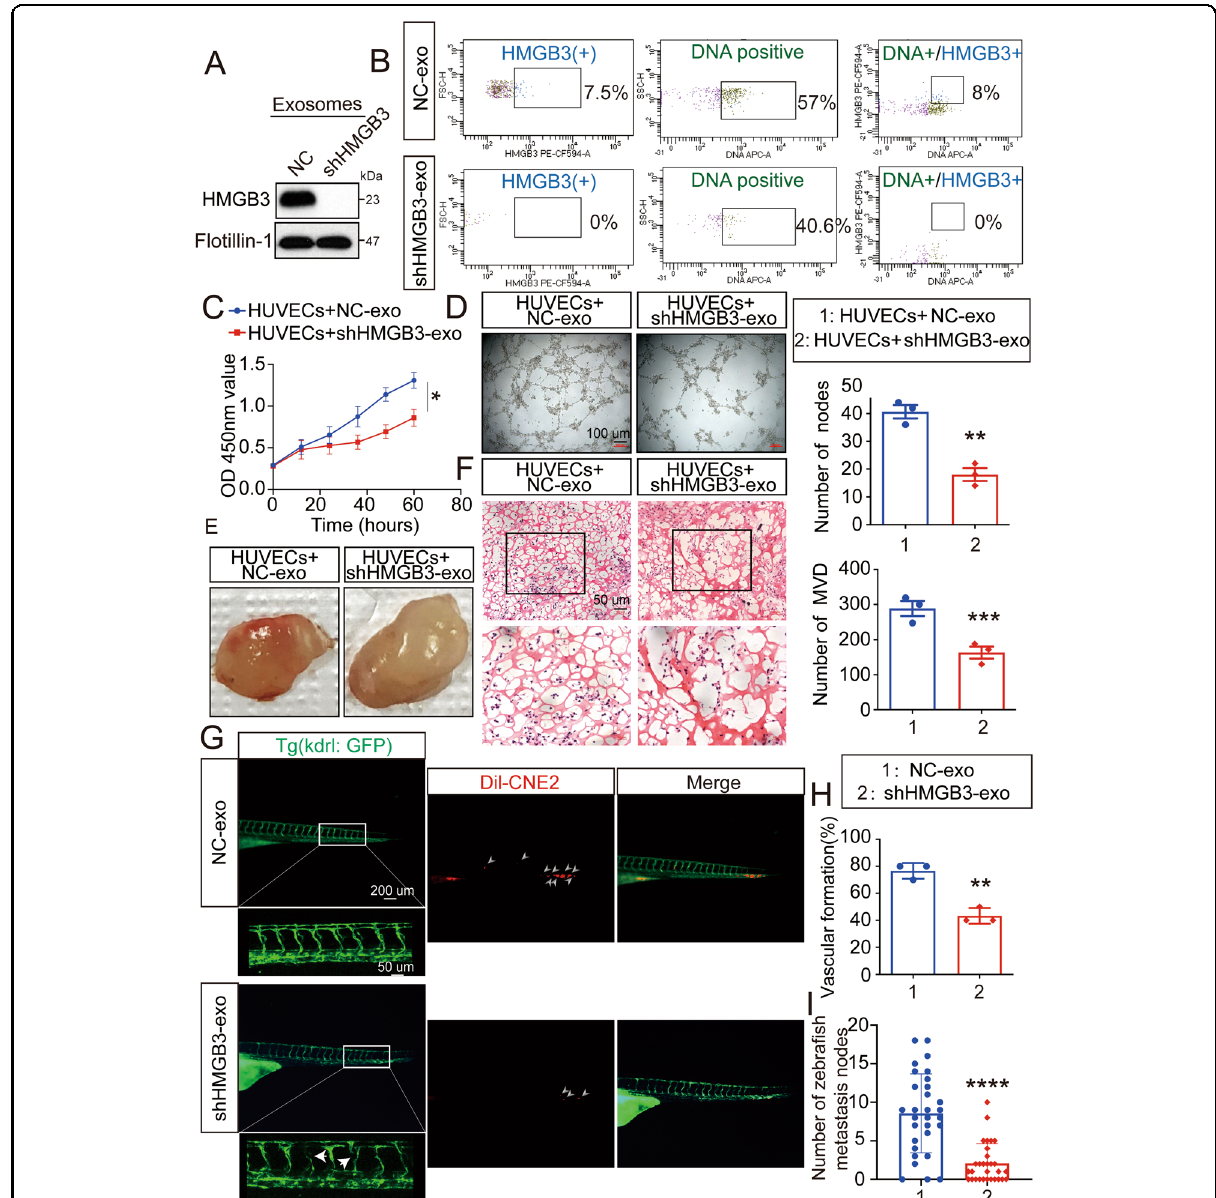
Fig. 7 nEXOs HMGB3 regulates metastasis via angiogenesis. A The HMGB3 levels of CNE2-NC-exo and CNE2-shHMGB3-exo were measured by western blot. B Flow cytometry analysis showed the percentage of gDNA and HMGB3 expression in exosomes of CNE2 cell supernatant. C The CCK8 assays were performed to measure proliferation of HUVECs treated with the two exosomes. D The tube formation assays were performed to measure tube forming ability of HUVECs treated with various exosomes. The scale bar represents 200 μ m. E Gross-observation exosomes modulated angiogenesis. F Frozen slices of the Matrigel plugs were stained with eosin-hematoxylin. The scale bar in 200× images represents 100 µm. The scale bar in 400× images represents 50 µm. G The GFP ‐ positive (green) intersegmental vessel (ISV) and CNE2 cells (red) are photographed by a microscope for 30 embryos per group. The red box was further photographed with a confocal microscope. The red arrow indicates a vascular defect. White arrows indicate metastasis nodes. H Percentage of vascular formation of ten embryos per group. I Quanti fi cation of migratory cell numbers. All experiments were conducted with three independent replicates. Mean ± SD, ** P < 0.05, ** P < 0.01, *** P < 0.001, student ’ s